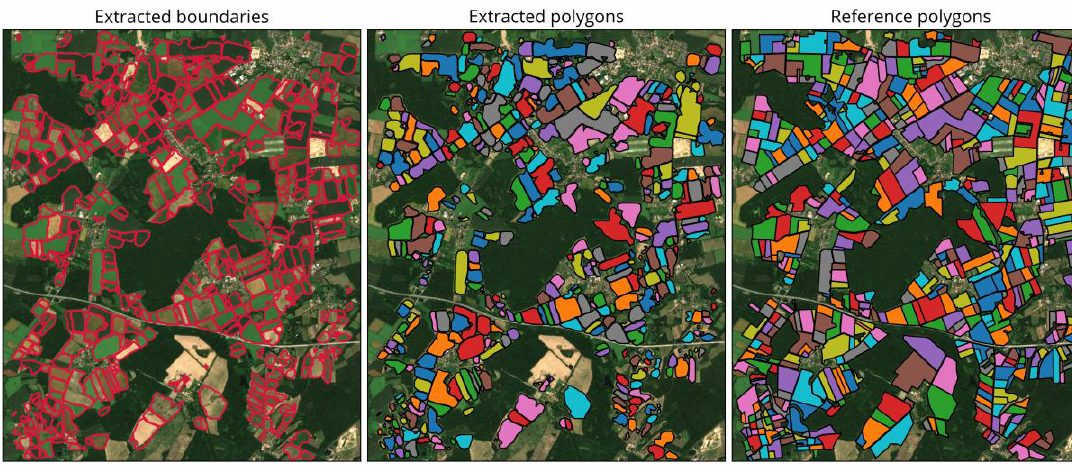
Figure 8. Result of the non-adaptive GGC field polygon extraction.